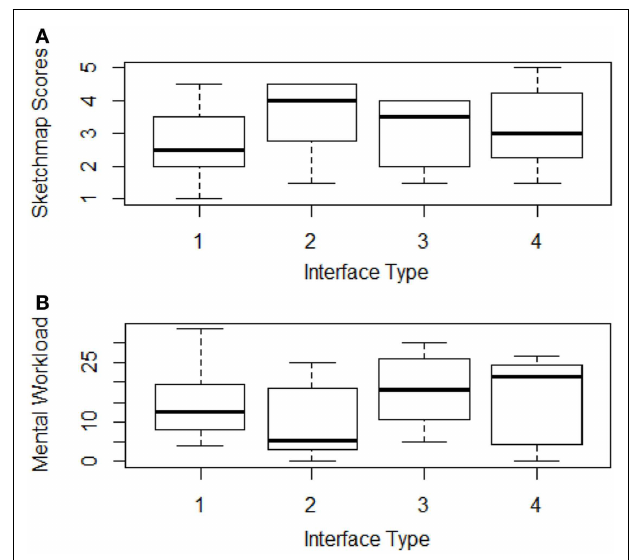
FIGURE 10 | Effects on users’ cognition for different interfaces as measured by (A) map sketch quality and (B) mental workload .